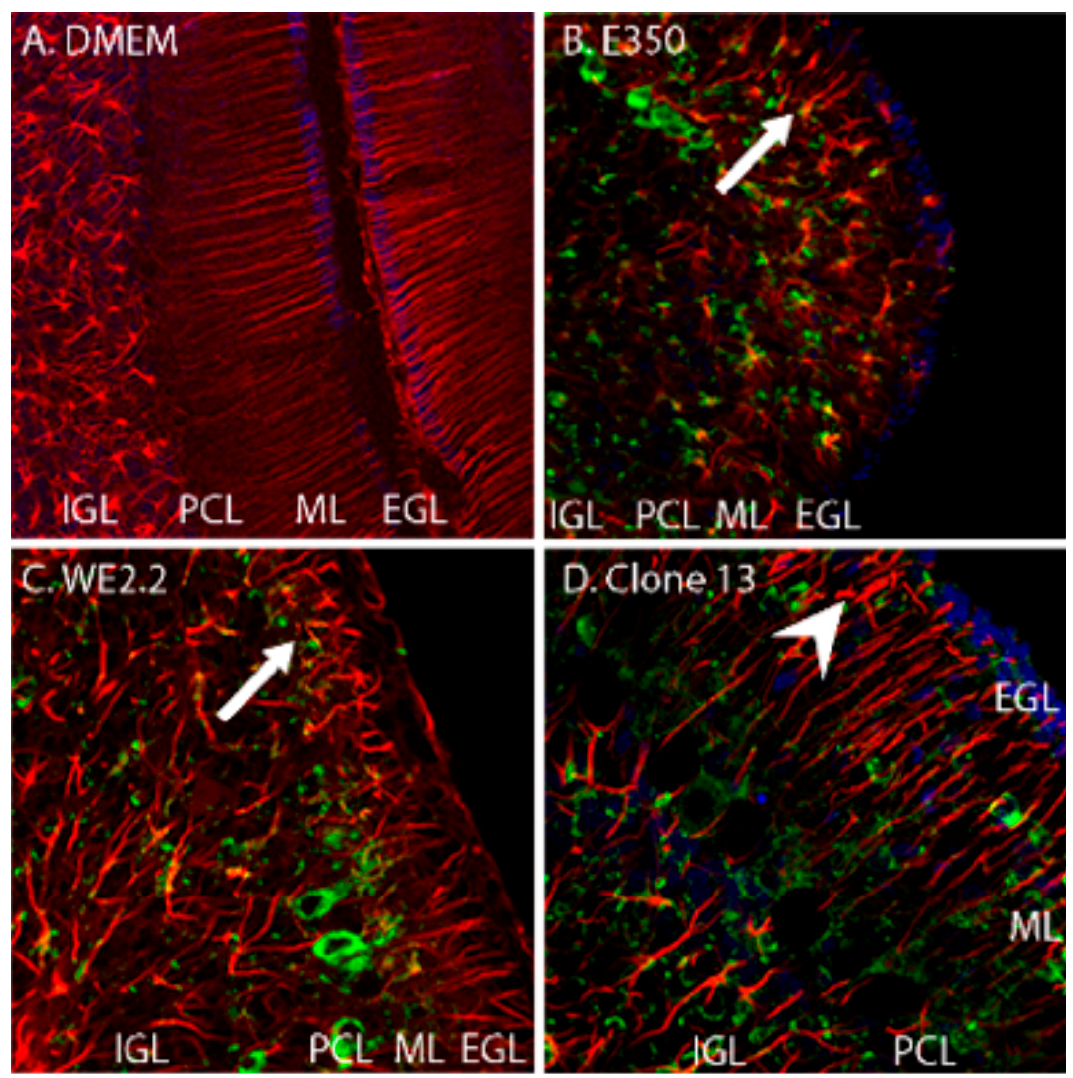
Figure 5. The different strains of LCMV induced different forms and severity of Bergman glial pathology. Pictured here are immunohistochemically stained (GFAP: red, LCMV: green, DAPI/nucleated cells: blue) of PD14 cerebellar tissue. ( A ) In control (uninfected) animals, Bergman glia are GFAP-positive cells that have an orderly, parallel, and unbranched pattern extending radially through the molecular layer. ( B ) In the animals infected with E350, the Bergman glia structure is radically altered (arrow). The cells are substantially foreshortened, branch abnormally, and have lost their parallel arrangement. ( C ) In animals infected with WE2.2, Bergman glia structure is also substantially altered (arrow), but less severely than that observed with E350. ( D ) In the animals infected with Clone 13, the Bergman glia were far less pathologically affected. The Bergman glia exhibited some abnormal branching (arrowhead) and deviation from their normally straight shape, but the length of their processes and their parallel configuration were generally preserved. IGL = Internal granule cell layer; PCL = Purkinje cell layer; ML = Molecular layer; EGL = External granule cell layer. Magnification is 200× for A,B,C, and D.